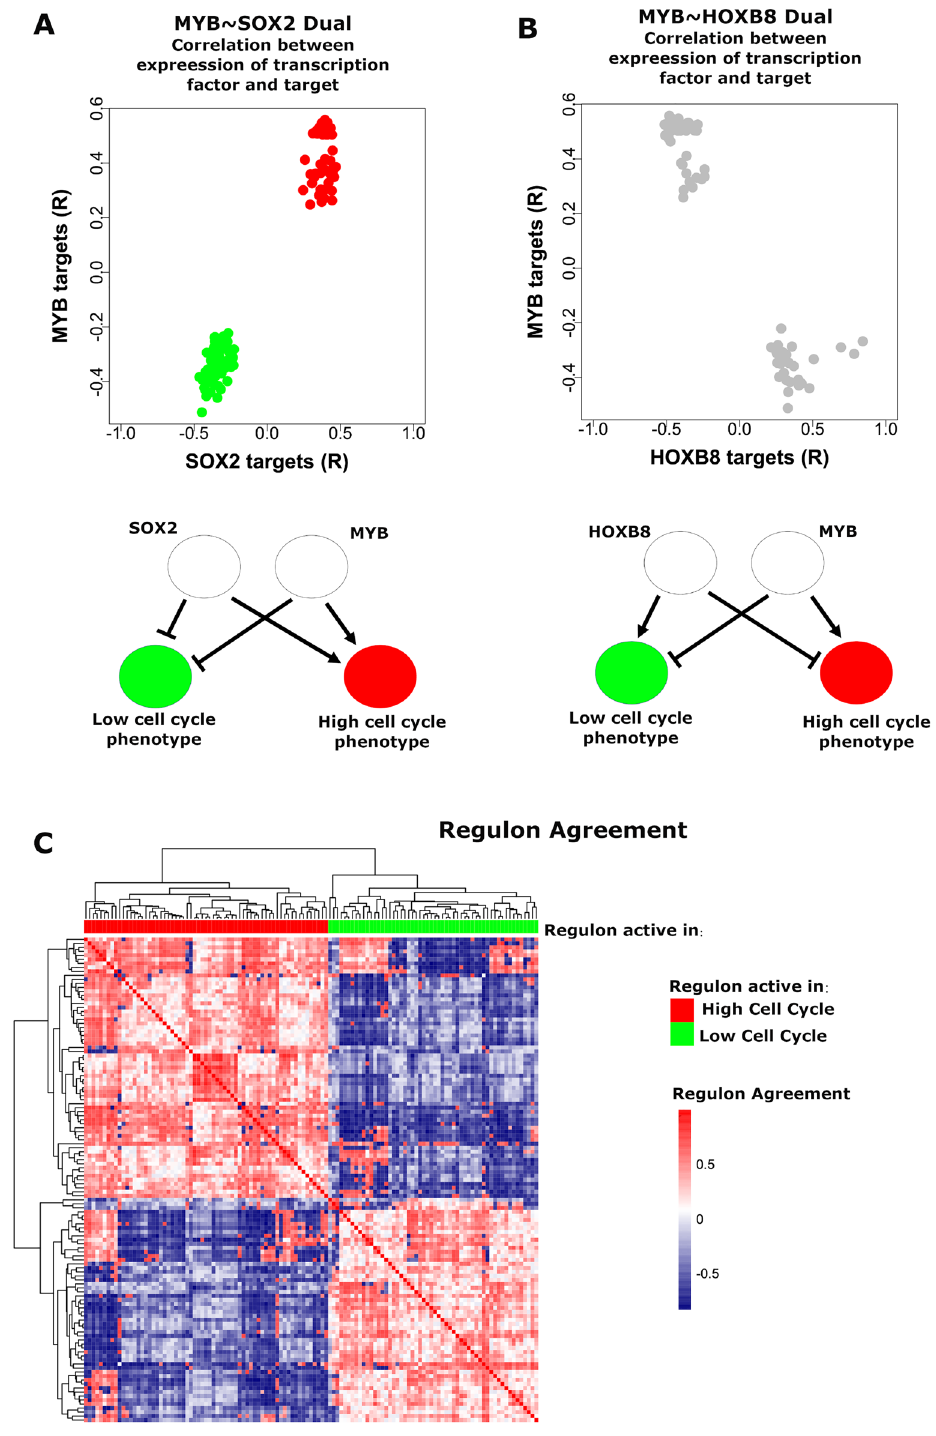
Figure 4. Dual regulons analysis. Two TF regulon duals are selected for illustration, ( A ) MYB ~ SOX2 and ( B ) MYB ~ HOXB8. For each, a dot plot demonstrates the correlation (R) between expression of each TF and each of its targets, for all targets shared by the TF pair (i.e. each dot corresponds to a target shared by the two TFs, and the value is the correlation between expression of the target and the given TF). Red dots indicate positive correlation, blue dots indicate negative correlation, and grey dots indicate opposite correlation. A schematic is also shown for each, demonstrating the effect each TF putatively has on the phenotype, arrows indicating stimulation and flat bars indicating inhibition. MYB and SOX2 both appear to positively regulate the High Cell Cycle phenotype and negatively regulate the Low Cell Cycle phenotype, while MYB and HOXB8 appear to have opposite effects. ( C ) TF regulons were clustered by Regulon agreement, the Spearman correlation between TF pairs and their relationship with target genes (i.e. correlation based on data points in A and B ), which divided TF regulons into two clusters, one enriched in regulons of high cell cycle activity, the other enriched in regulons of low cell cycle activity. Figures generated using expression data from Cohort